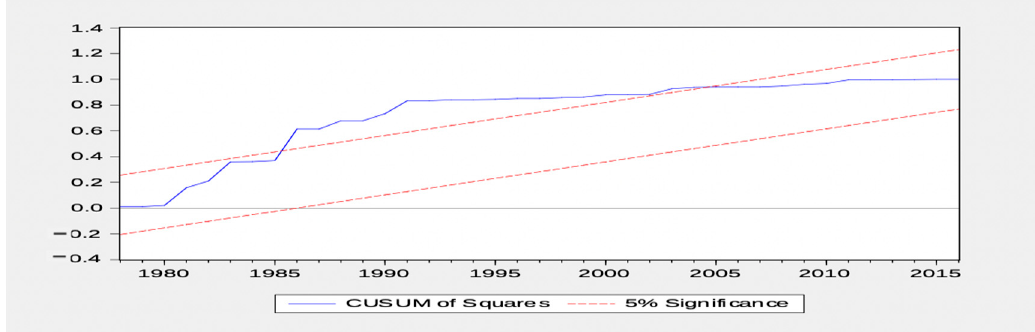
15 of 18 Figure A4. CUSUM Test (UAE). Figure A5. Square of CUSUM Test (UAE).